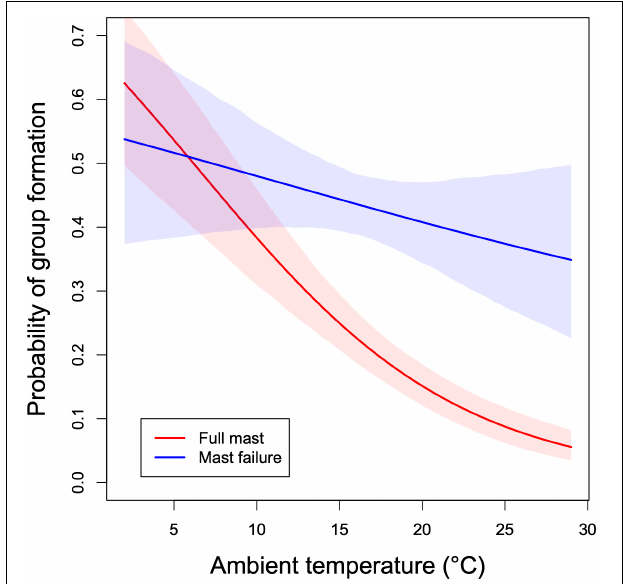
FIGURE 5 | Probability of group formation as a function of ambient temperature during the past 24 h in edible dormice. Groups consisted of 2–16 adults and yearlings of both sexes. Predictions ± 95% credible intervals from a Bayesian multilevel model for years of full mast seeding (red) and mast failure years (blue) of beech trees. Data from a 13-year mark-recapture study, Austria. Recomputed from data in Ruf and Bieber